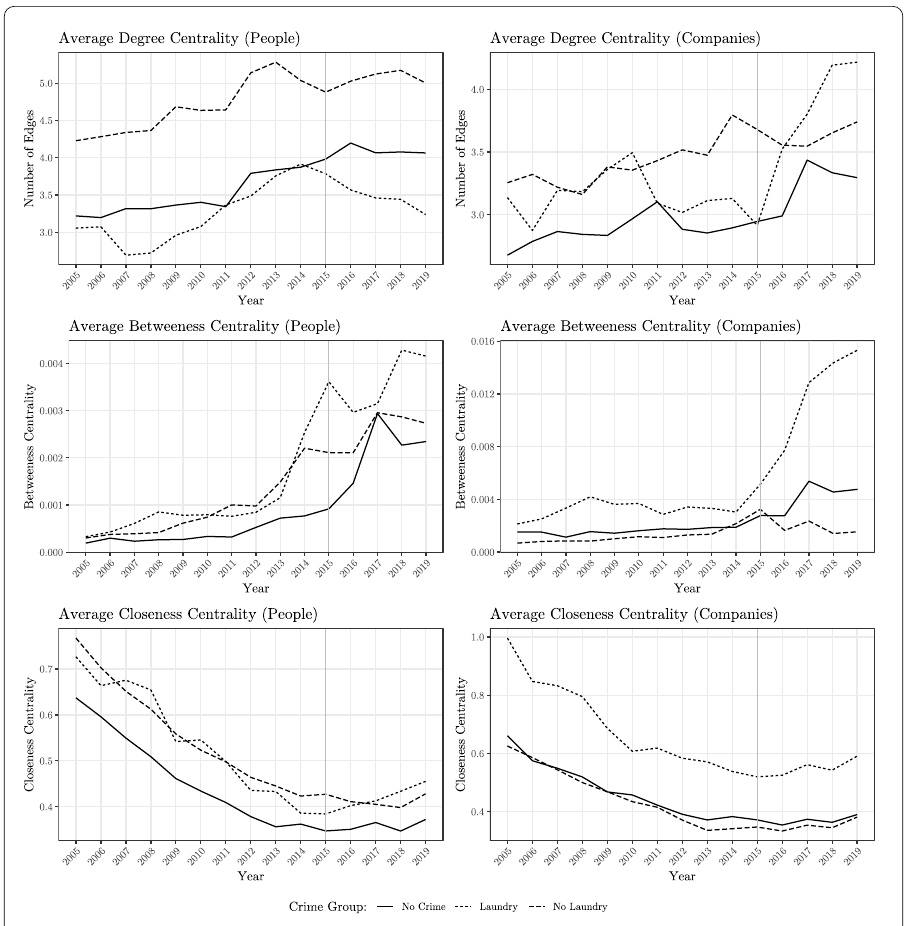
Figure 7 Cluster average of individual centrality measures. This figure shows 6 line charts that show the development for individual nodes within a cluster type on average degree centrality, average degree centrality and average closeness centrality, separated into people and